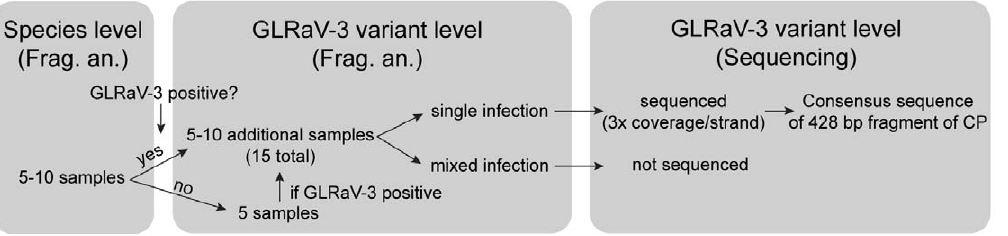
Figure 1. Schematic illustration of sampling design used in this study. Samples were first screened for different GLRaV species, then two approaches were used to type GLRaV-3. Frag. An. stands for ‘Fragment analysis’, a typing approach described in Materials and Methods.